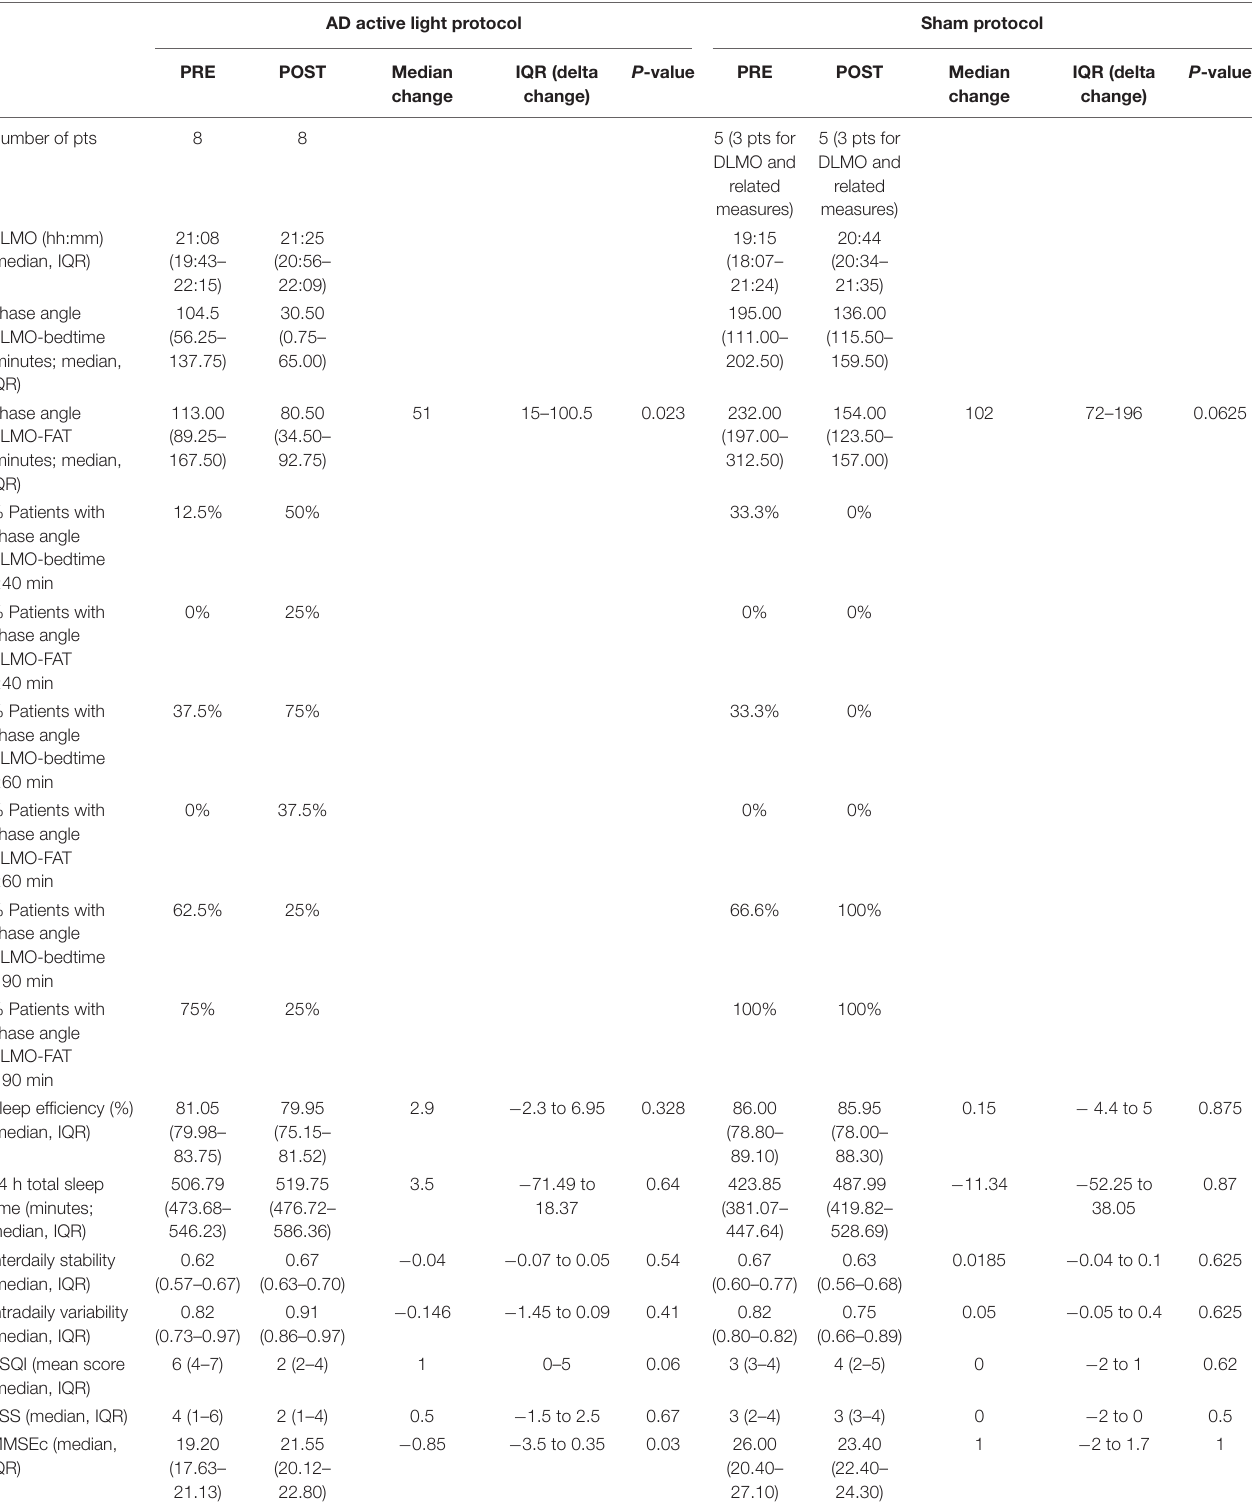
TABLE 3 | Primary and secondary outcomes, and other circadian parameters before (PRE) and after (POST) active light/sham protocol. AD active light